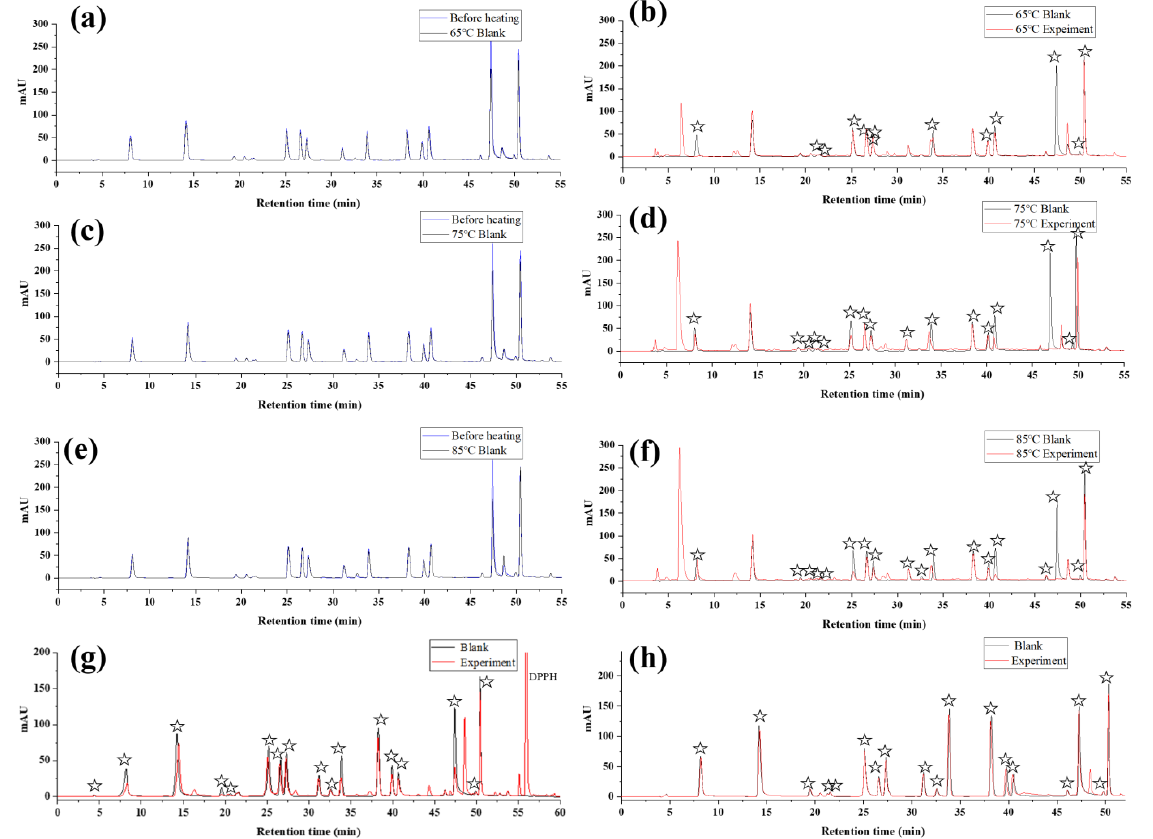
Figure 2. Thermal stability of polyphenols at different temperatures ( a , c , e ) and results of screening antioxidants based on AAPH radicals ( b , d , f ), DPPH radicals ( g ) and ABTS radicals ( h ) from mixed polyphenols. The pentagram in figure represents a peak reduction of the compound based on a reaction with radicals. As shown in Table 1, at 65 °C, the percentage of peak area reduction of polyphenol compounds due to heating was between 3.03 and 23.92%; at 75 °C, the percentage of peak area reduction of polyphenols was between 4.32 and 34.80%; and when the temperature was increased to 85 °C, the percentage decrease in the peak area of polyphenols was be- tween 4.65 and 39.20%. At 65 °C, we detected 16 compounds whose peak area reduction was due to the reaction with AAPH radicals; the percentage of peak area reduction was between 1.84 and 100%, and most of the peak area reduction rates were around 10%; at 75 °C, we detected a reduction in the peak area of 19 compounds. Due to the reaction with AAPH radical, the percentage of peak area reduction was between 1.46 and 100%, and most of the peak area decrease rate was approximately 50%; at 85 °C, we detected peak area reduction for 17 compounds, due to the reaction with AAPH radical, the percentage of peak area reduction was between 0.3 and 100%. The degradation rate of polyphenols